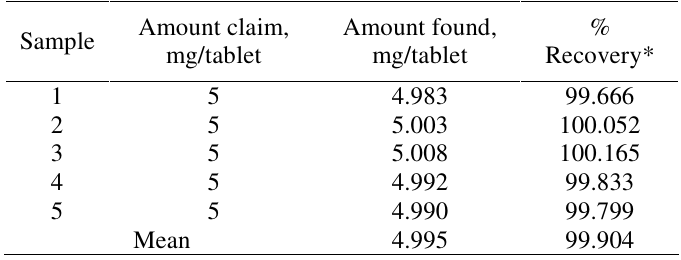
Table 2. Results of HPLC assay and recovery